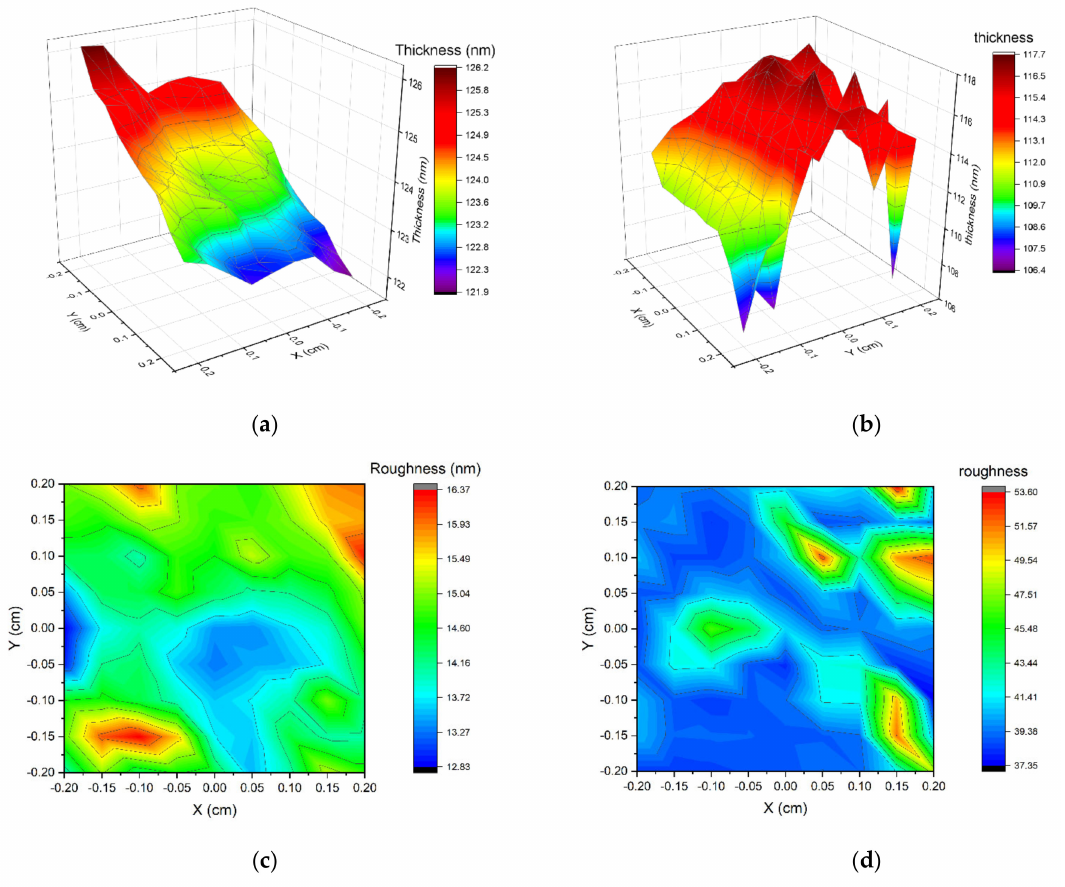
Figure 7. Thickness and roughness of two samples calculated from ellipsometric